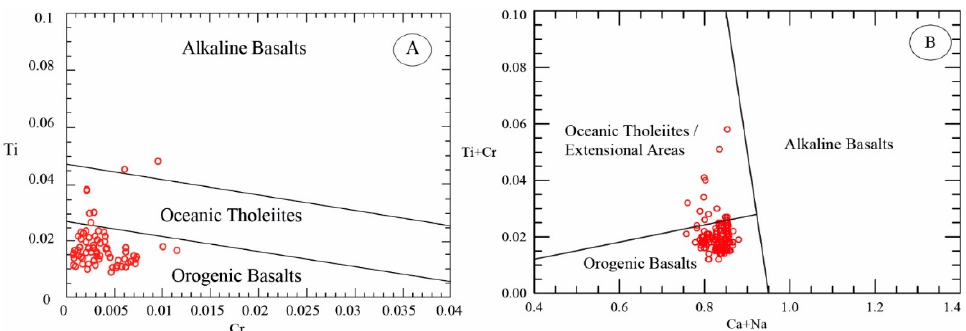
Figure 16. Position of the analyzed clinopyroxenes in the diagrams of [64]: ( A ) Ti–Cr, ( B ) Ti + Cr–Ca + Na. Red circles indicate the analyzed clinopyroxenes.